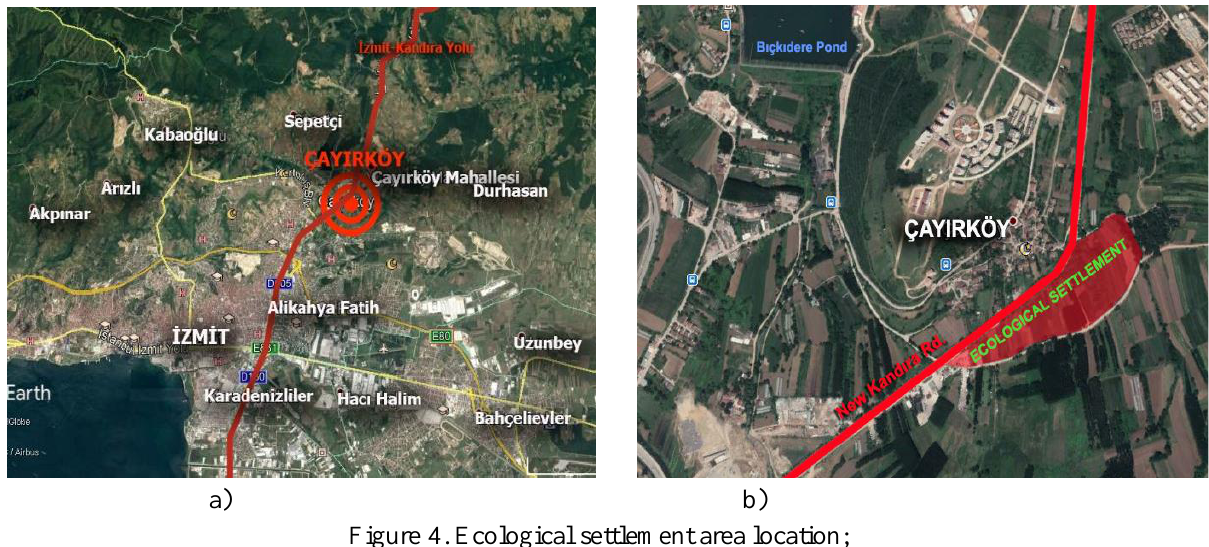
Figure 4. Ecological settlement area